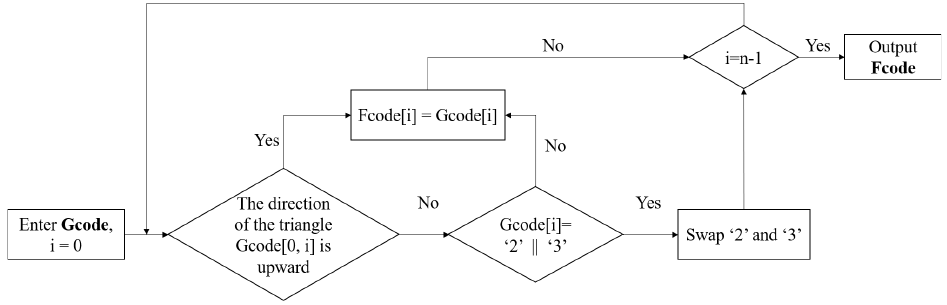
Figure 12. Algorithm flow chart of conversion from Goodchild encoding to modified direction encoding.